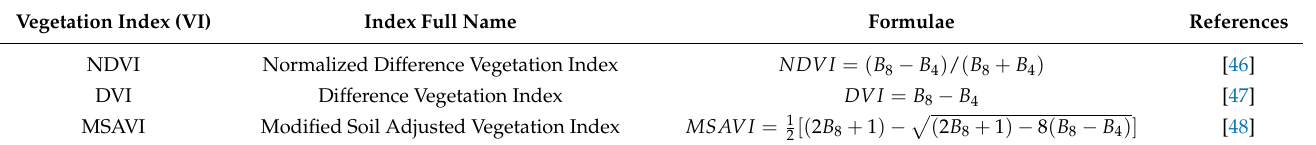
Table 3. Adopted vegetation indices calculated from Sentinel-2 data.